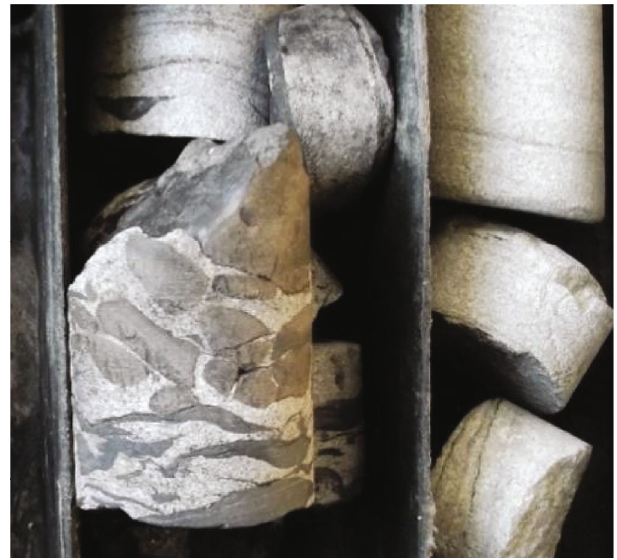
Figure 7: Argillaceous inclusions in sandstone.